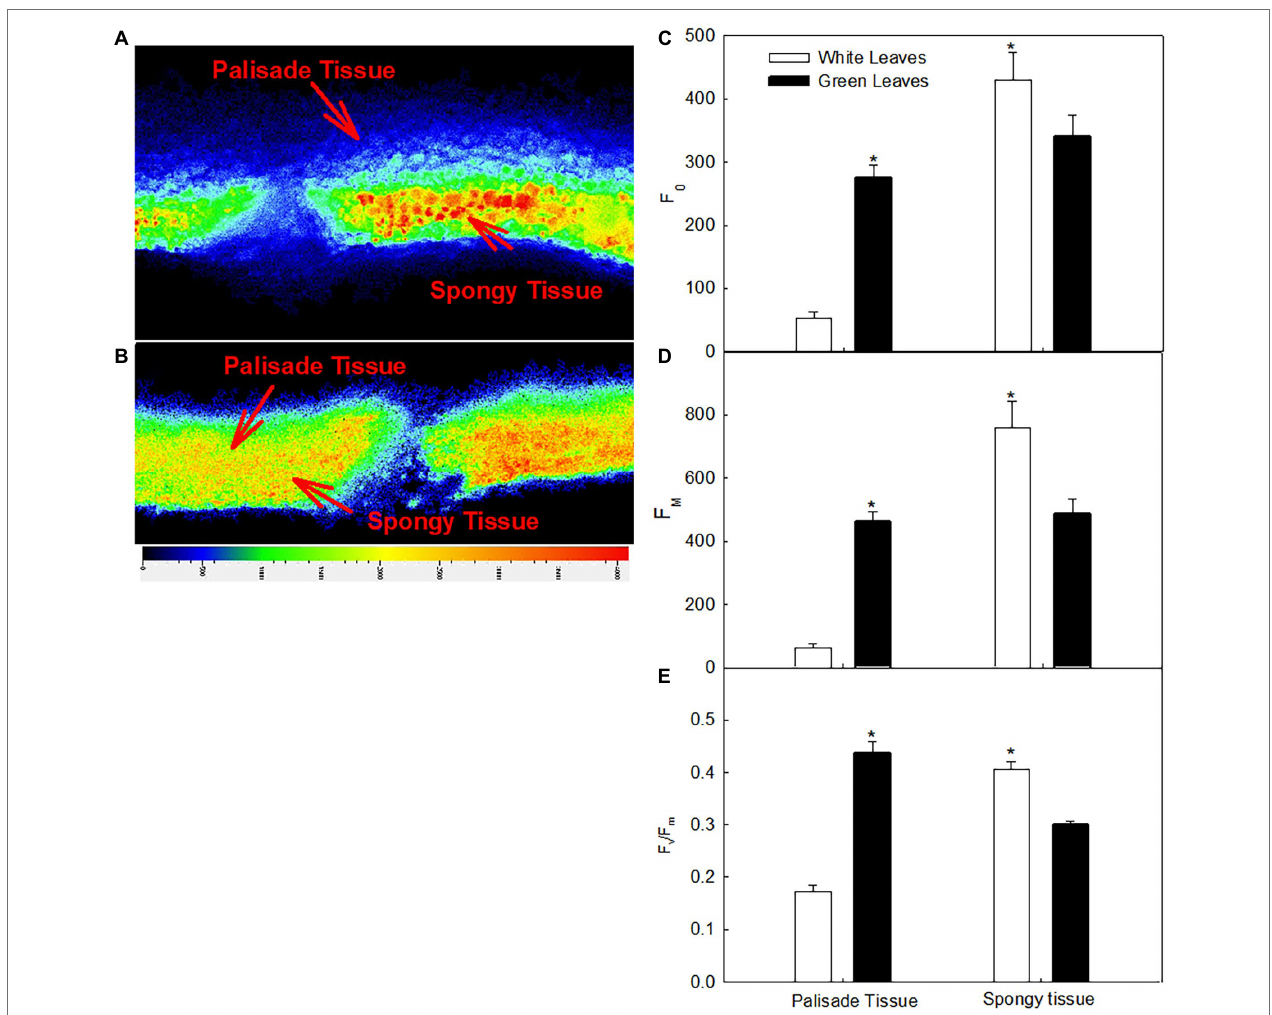
FIGURE 6 | Changes in the chlorophyll fluorescence images and quantum yield of different tissues in white (A) and green leaves (B) ; F 0 (C), F m (D) , and F v / F m (E) of different tissues in white and green leaves. Data represent means ( n = 5) ±